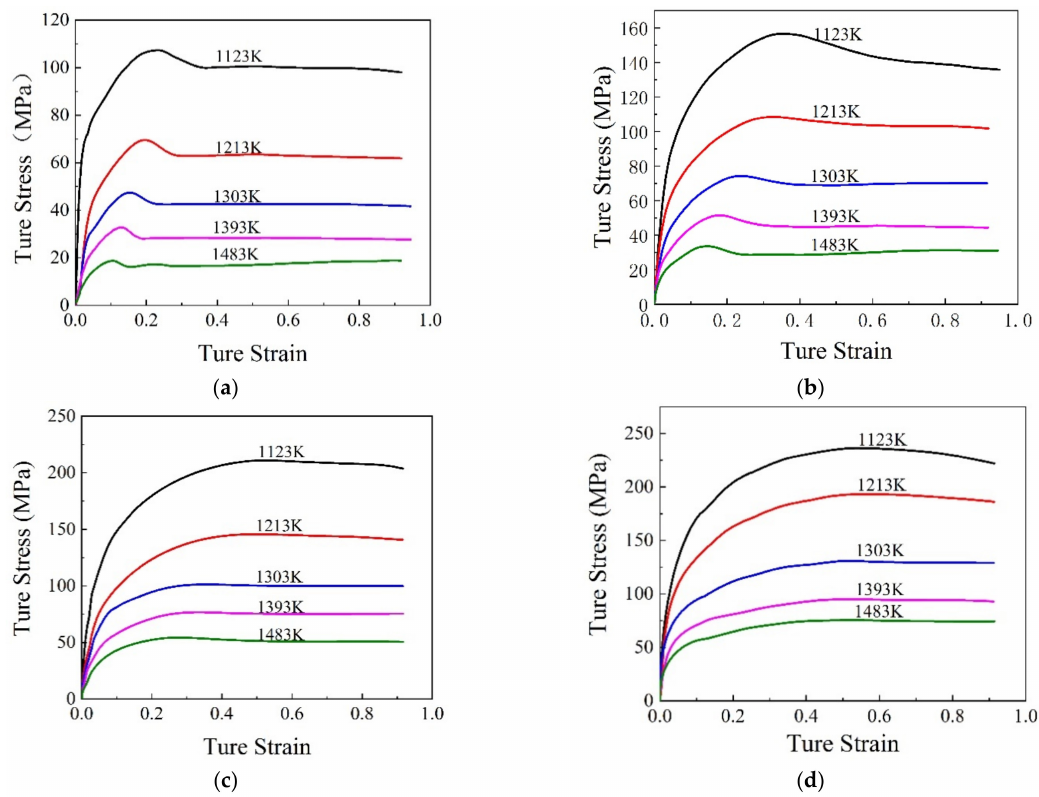
Figure 4. True stress–strain curves of SAE 5137H steel under different deformation temperatures with strain rates ( a ) 0.01 s − 1 , ( b ) 0.1 s − 1 , ( c ) 1 s − 1 , ( d ) 10 s − 1